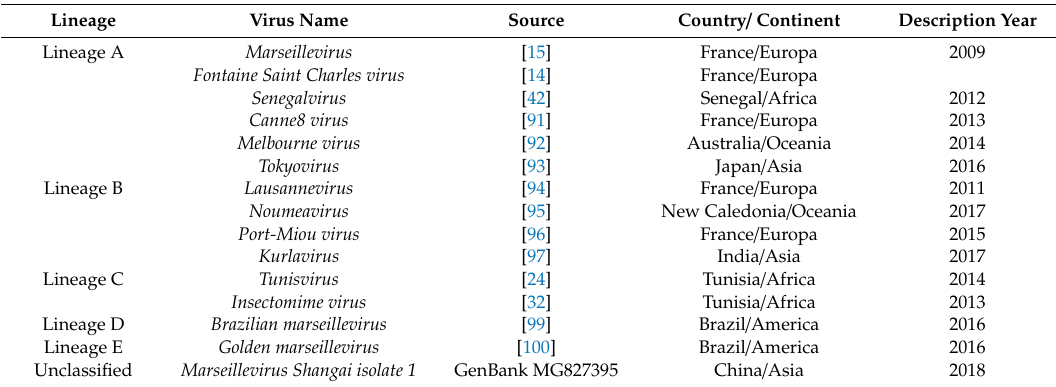
Table 3. List of the 15 published Marseillevirus